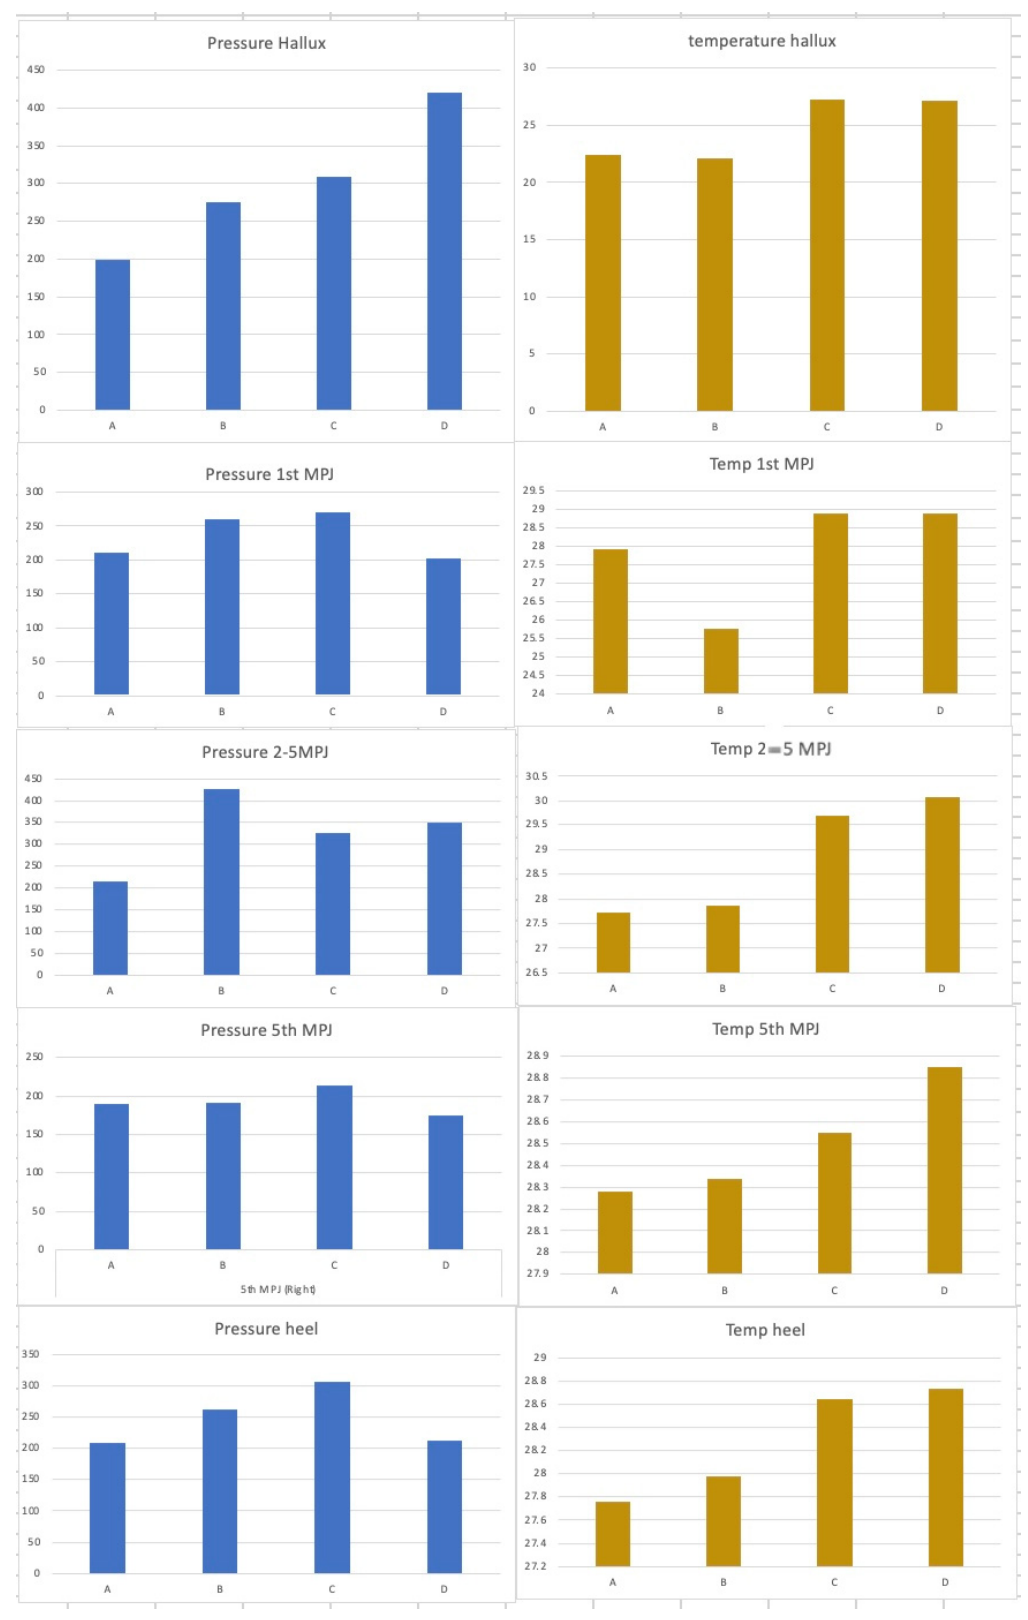
Figure 4. Mean plantar pressure and temperatures for all areas and groups.